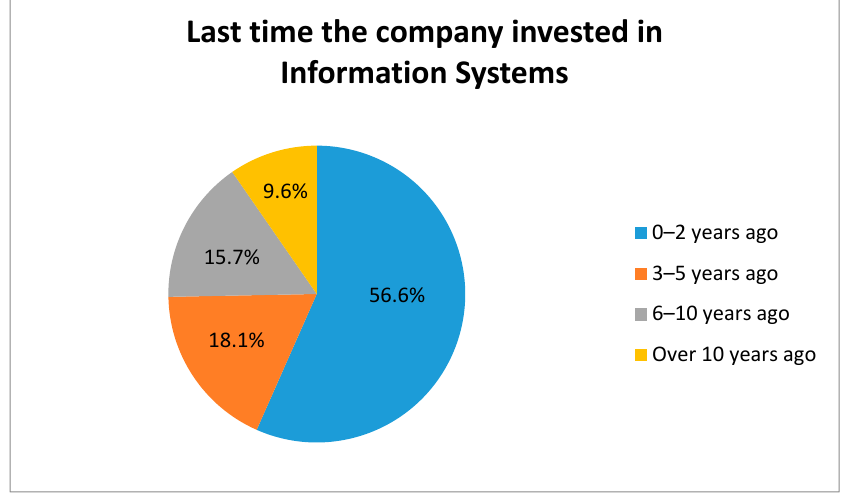
Figure 2. Last time the companies invested in IS.